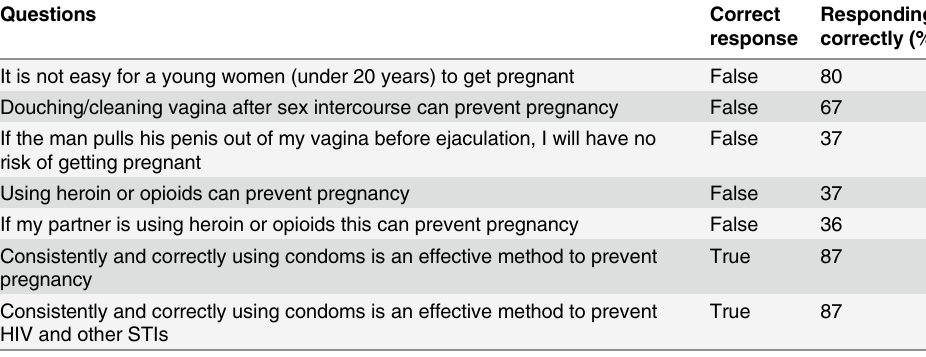
Table 1. Proportion correctly answering knowledge questions (N =